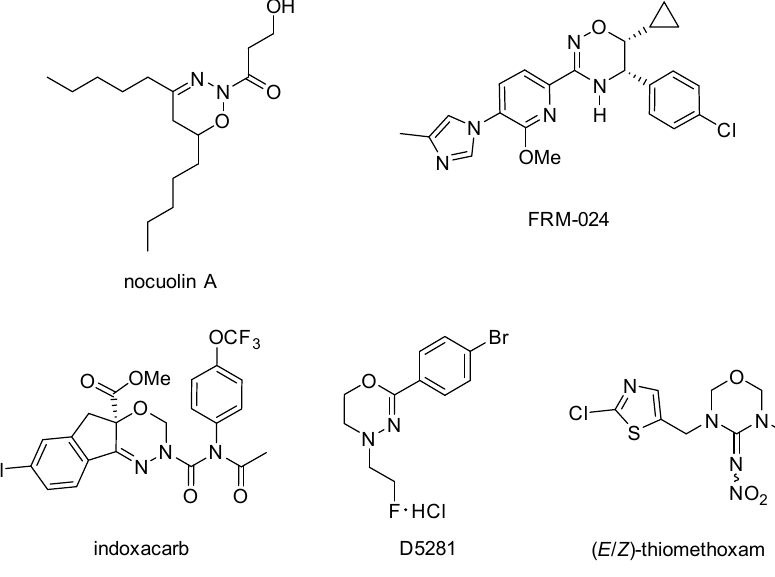
Figure 1. Bioactive oxadiazines.